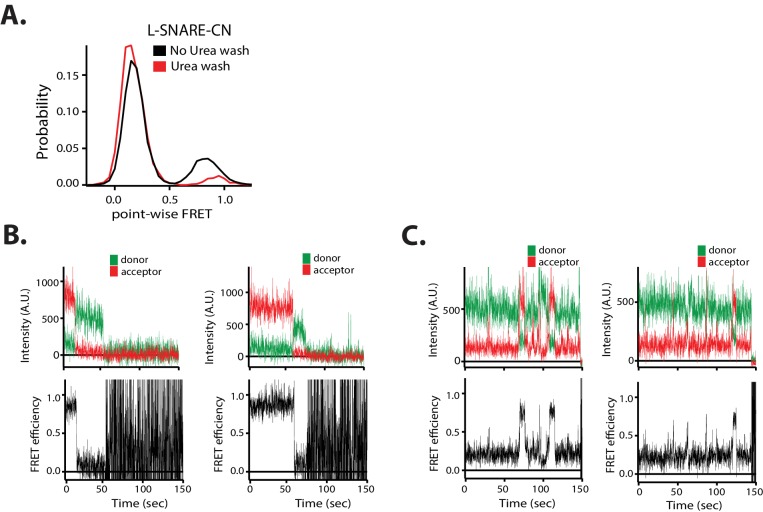
A 7.5 M urea wash prevents improperly assembled L-SNARE complexes.(A) FRET efficiency histogram corresponding to disassembly of surface tethered L-SNARE-CN with an anti-parallel-reporting FRET labeling pair when purified with and without a supplemental 7.5 M urea wash prior to tethering. Note that NSF and αSNAP were not included in these experiments. (B) Representative single-molecule fluorescence intensity time traces of L-SNARE-CN in anti-parallel configurations in the absence of disassembly factors and without urea wash (top panels). The fluorescence intensities were converted to FRET efficiency time traces (bottom panels). (C) Representative single-molecule fluorescence intensity time traces of L-SNARE-CN (prepared with a urea wash step during purification) in the presence of disassembly factors (top panels). The fluorescence intensities were converted to FRET efficiency time traces (bottom panels).